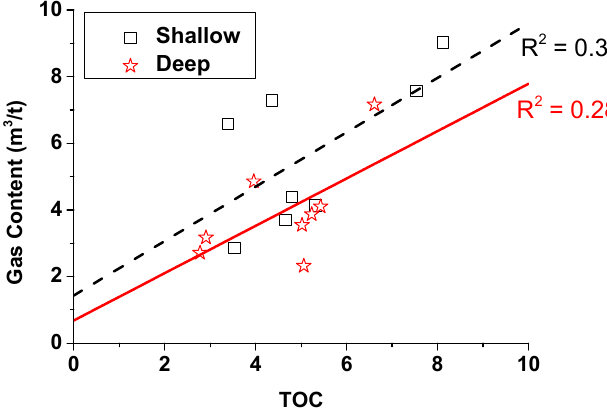
Figure 8. Relationship between gas content and TOC. Figure 7. Relationship between gas content and formation pressure.